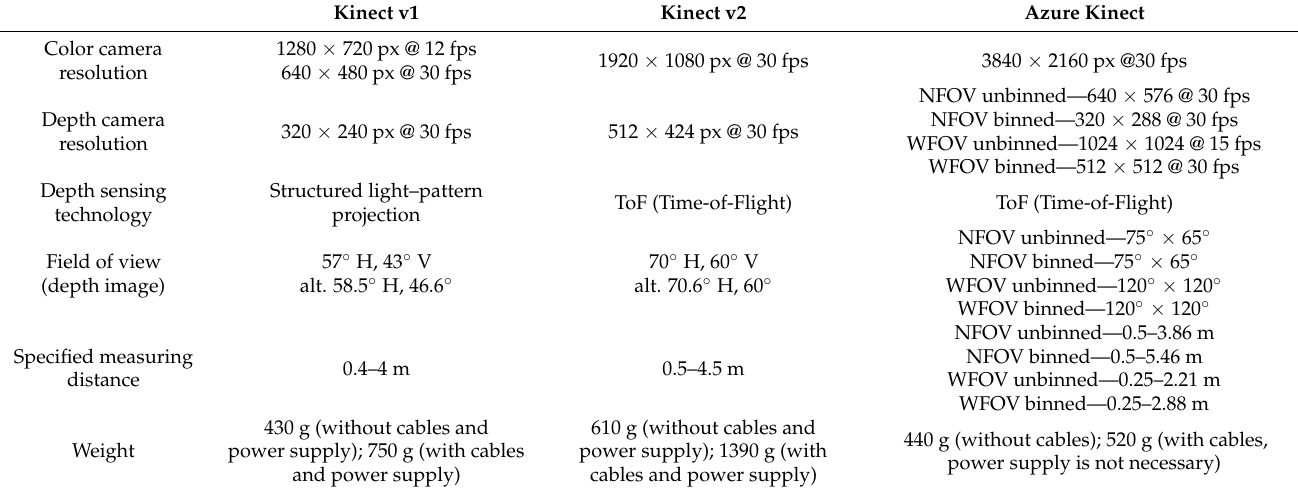
Figure 2. Schematic of the Azure Kinect. A comparison of the key features of all three Kinects is found in Table 1. All data regarding Azure Kinect is taken from the official online documentation. Table 1. Comparison of the three Kinect versions